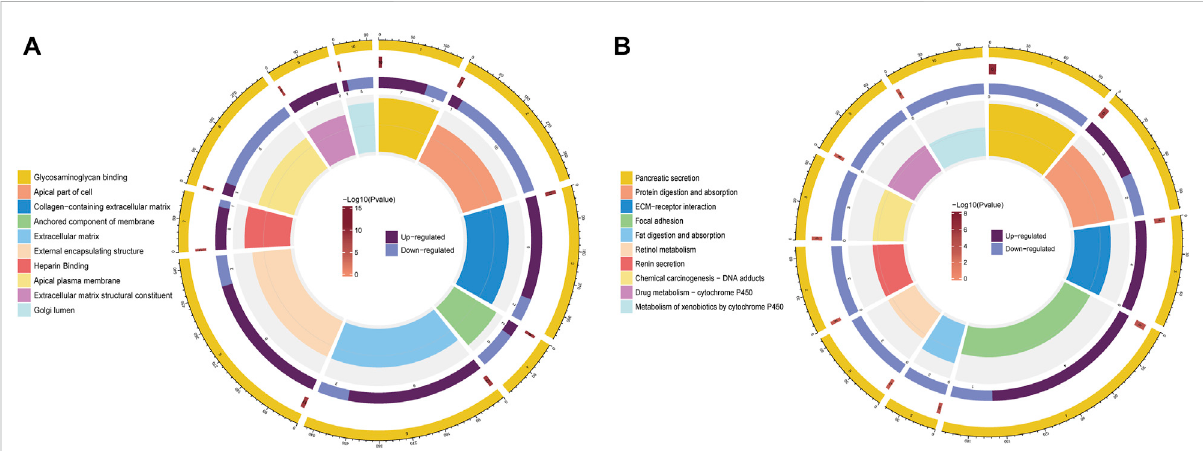
FIGURE 7 Functional enrichment analysis of DEGs between the high- and low-risk groups. (A) Analysis of DEGs for GO enrichment. (B) Analysis of KEGG enrichment for